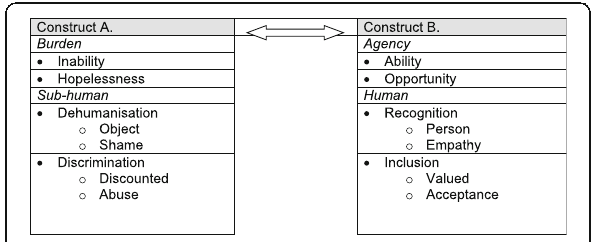
Fig. 2 Schematic representation of organizing and basic themes as opposing